Question: Condense the content of this figure into a single sentence.
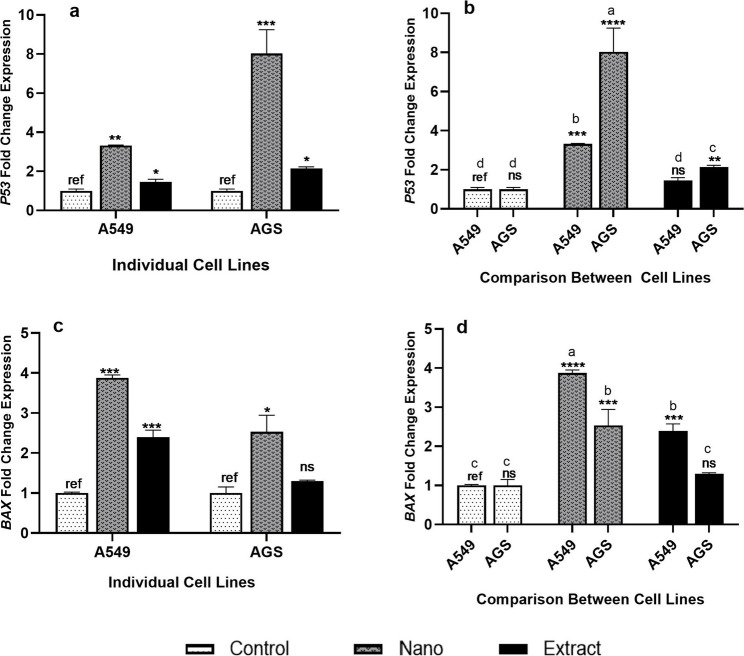
Answer: The effects of N. glomerulosa extract and its silver-loaded nanoemulsion of N.glomerulosa extract on apoptosis-related gene expression in gastric cancer (AGS) and lung cancer (A549) cell lines: ( a-b ) Relative fold change expression in Tp53 gene expression for each cell line separately ( a ) and comparison between cell lines ( b ). ( c-d ) Relative fold change expression in the BAX gene expression for individual cell lines ( c ) and comparison between cell lines ( d ). Data are presented as mean ± SD ( n = 3). Significant differences are indicated by letters and asterisks. (*significant difference at P < 0.05; **significant difference at P < 0.01; *** significant difference at P < 0.001; **** significant difference at P < 0.0001; ns: nonsignificant; ref: reference group)